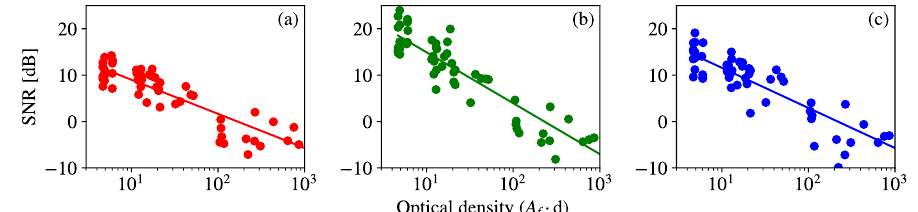
Figure 8. Empirical signal-to-noise ratio (SNR) values obtained from captures at G V = 11 dB plotted against optical density values at fixed link range d and with A f values emulated by the presence of fog. The plot in ( a ) corresponds to R channel, ( b ) to G channel, and ( c ) to B channel, and their respective fitted